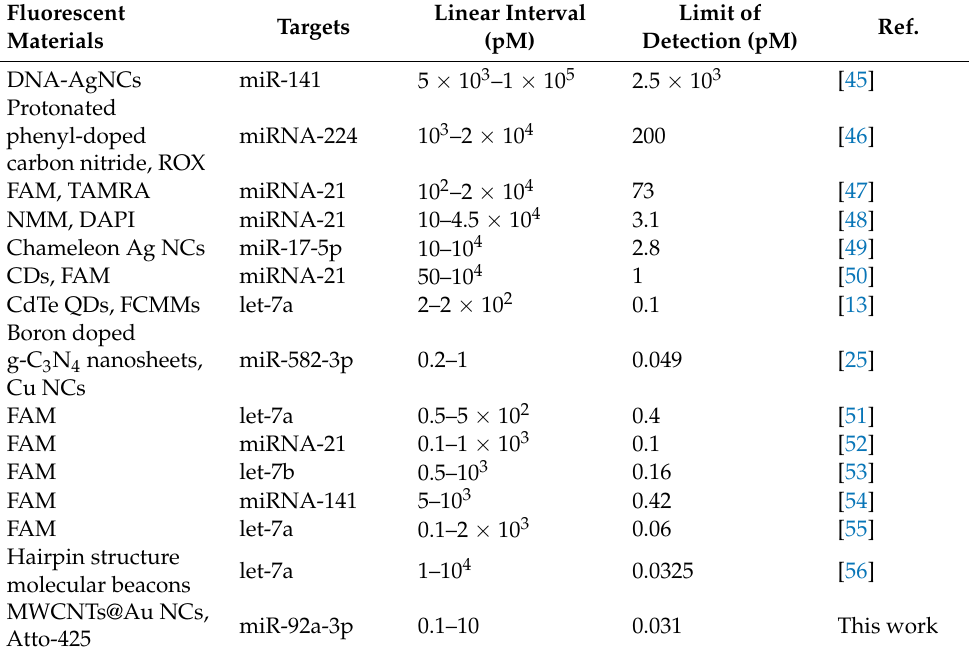
Table 2. Comparison of the detection performance of the ratiometric fluorescent biosensors and DSN signal amplification-based fluorescent biosensors for